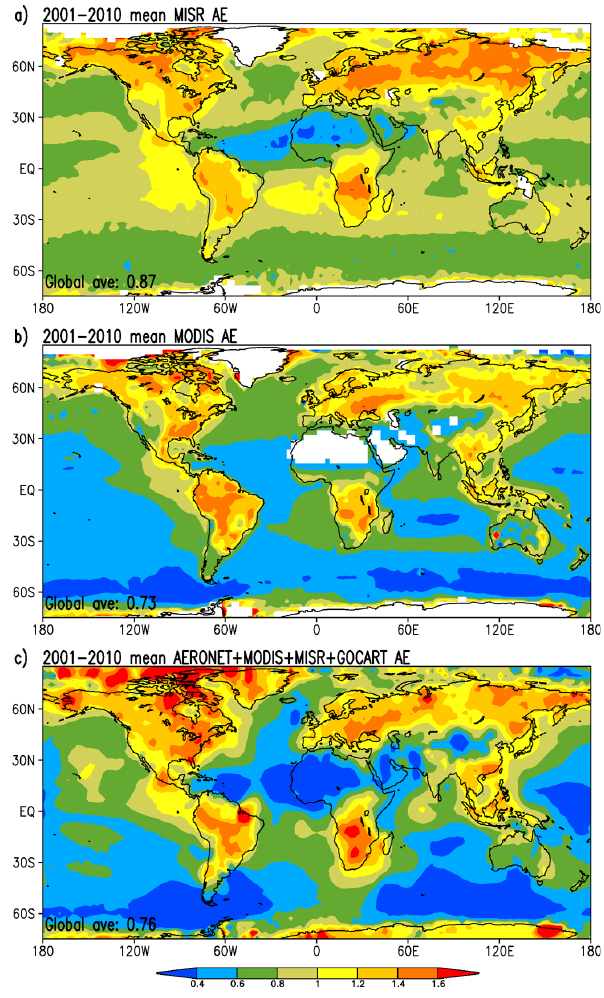
Fig. 4. ˚Angstr¨om exponent (AE) from (a) MISR, (b) MODIS, and (c) our best estimate. Shown are the 10-yr (2001–2010) AE aver- ages, using the 10-yr mean AOD at each wavelength.